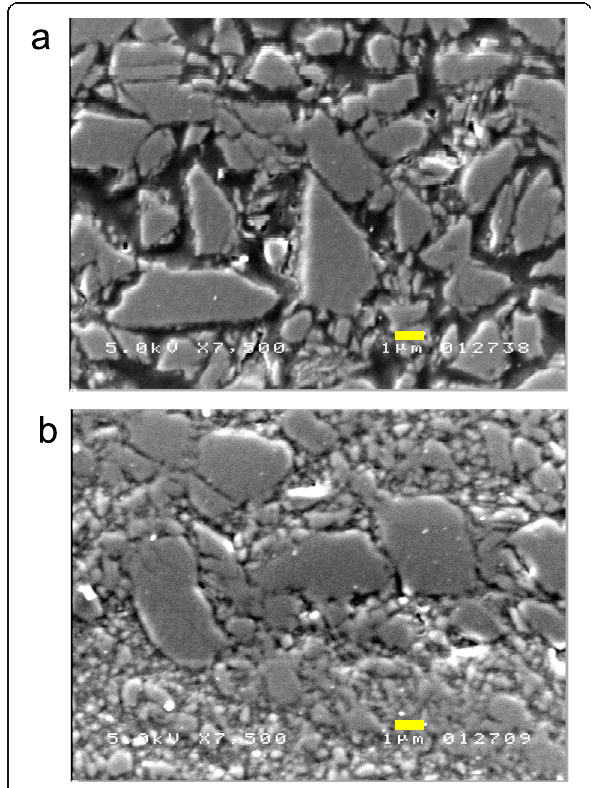
Fig. 5 SEM images of feldspar samples after experiments conducted at 400 °C. a Dry condition; b wet condition. After the experiments under wet conditions, the feldspar samples were clearly rounded, which is supportive of pressure solution taking